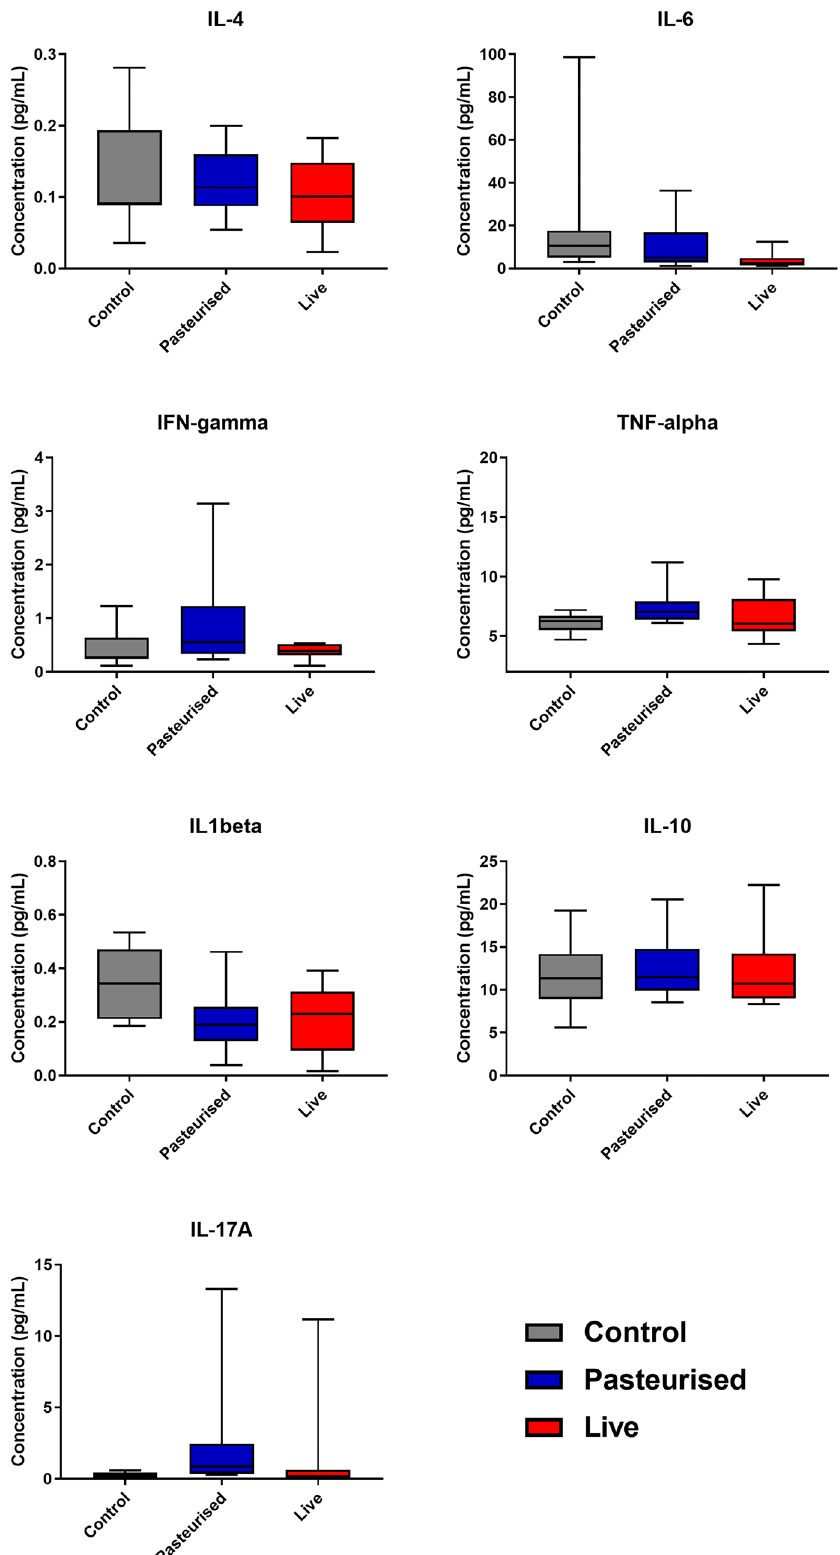
Figure 7. Cytokine levels in plasma after 29 days of P. copri gavage (n =